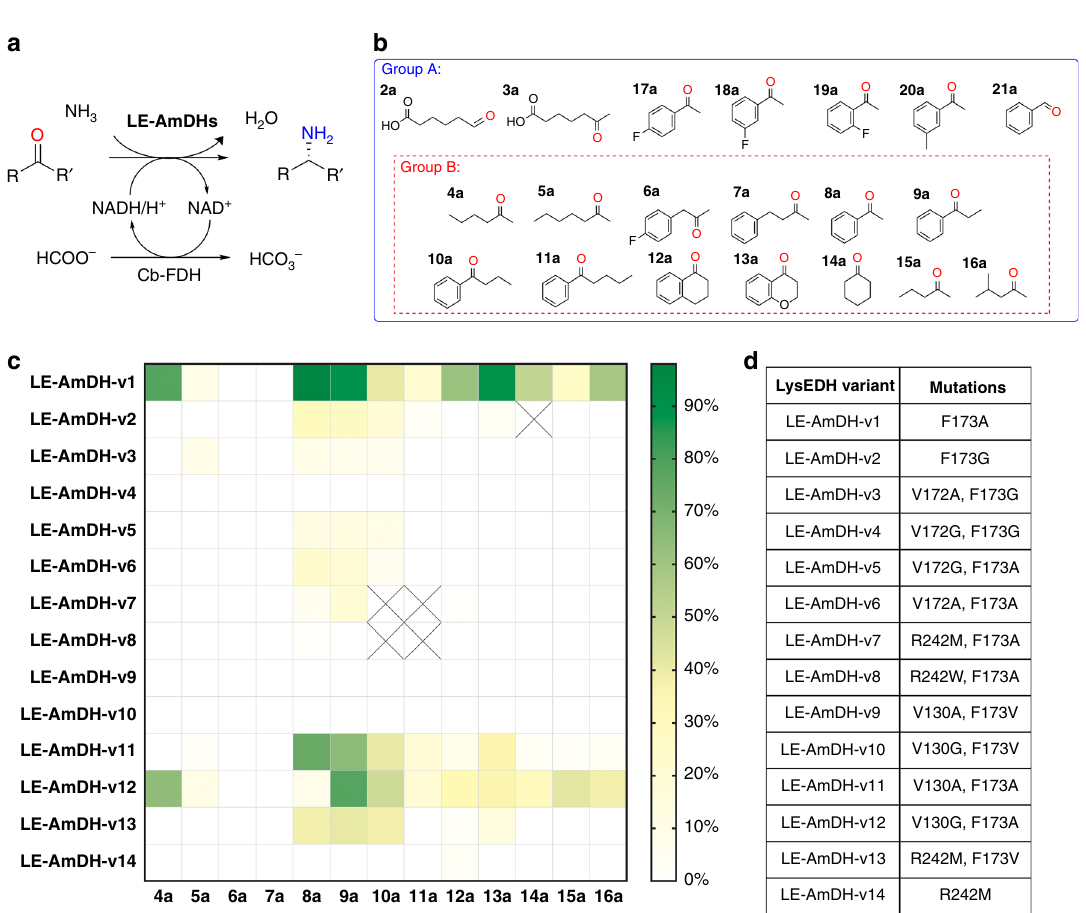
Fig. 2 Initial screening with LE-AmDH variants. a General scheme of the biocatalytic reductive amination performed by LE-AmDH variants. A catalytic amount of NAD + (1 mM) was applied. The reducing equivalents, as well as the nitrogen source originated from the buffer of the reaction: HCOONH 4 /NH 3 (pH 9.0, 2 M). The substrate concentration was 10 mM. AmDH and Cb-FDH were used in fi nal concentrations of 90 μ M and 19 µ M, respectively.